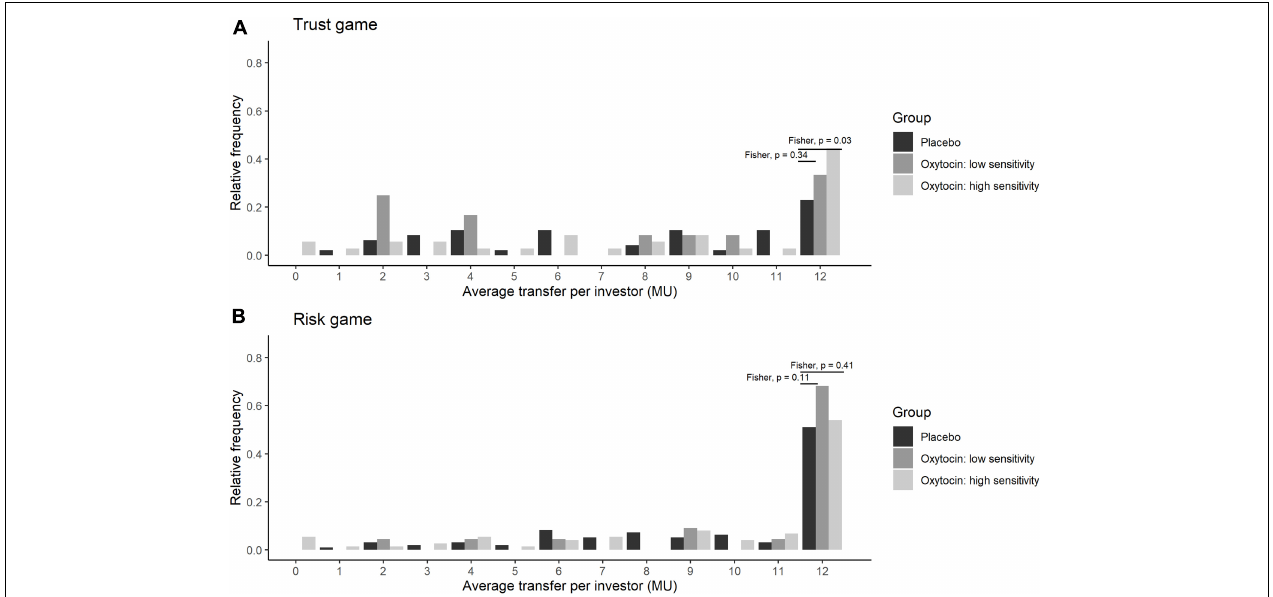
FIGURE 5 | Transfer amounts in the trust (A) and risk (B) games, stratified by sensitivity to oxytocin. The bars indicate the relative frequencies of the different invested amounts in monetary units (MU) averaged for all four rounds. White, gray, and black bars represent the relative frequencies in the high-sensitivity, low-sensitivity, and placebo groups, respectively. High and low sensitivity were defined as post-administration increases in oxytocin concentration being above and below the median increase, respectively. The x-axis represents the average transfer per investor. For instance, if the average transfer per investor equals 12, it means that the investor sent the maximum amount of MU in all four rounds. The difference in the number of participants who invested the maximum amount between the high-sensitivity ( n = 36) and placebo ( n = 48) groups was significant (Fisher exact test; P = 0.03, one-sided). In contrast, the corresponding difference between the placebo and low-sensitivity ( n = 12) groups was not significant (Fisher exact test; P = 0.34, one-sided).